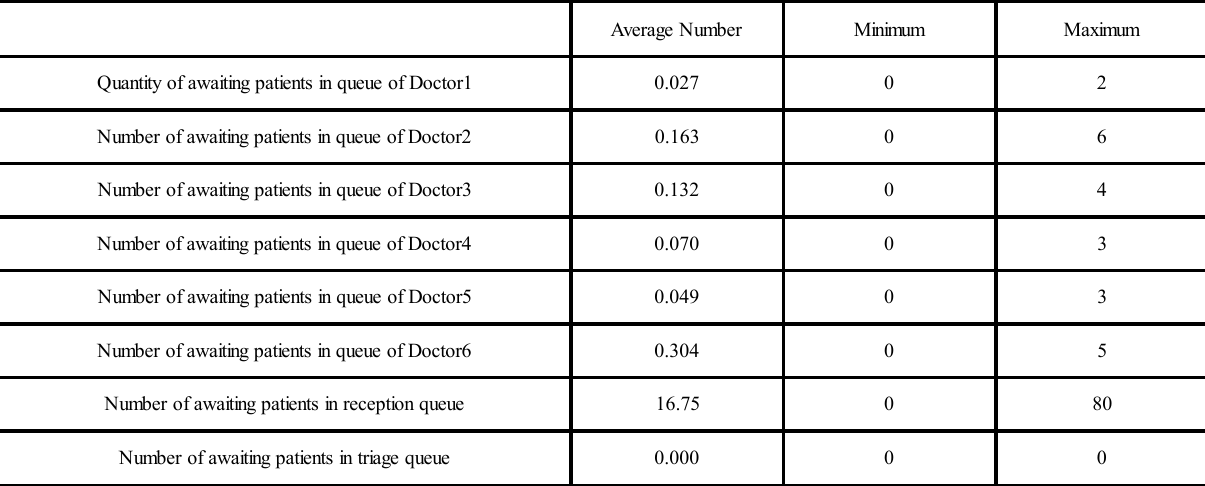
TABLE 4. QUANTITY OF AWAITING PATIENTS IN THE WAITING LINE